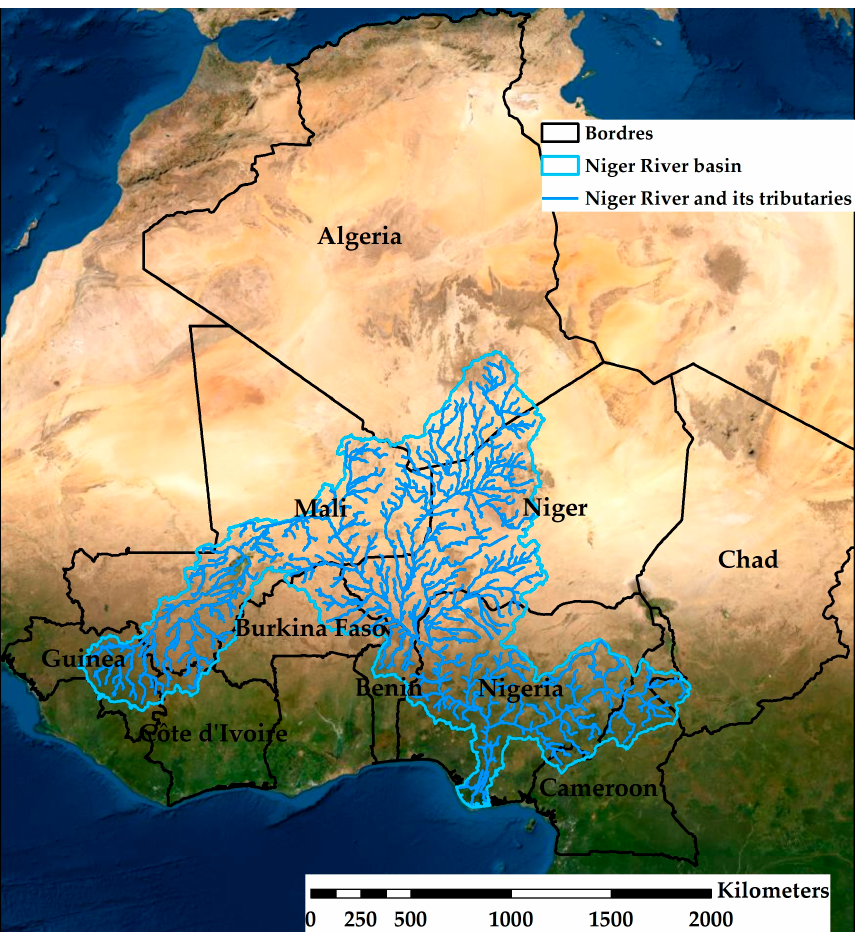
Figure 1. Map of the Niger River basin. The map shows the ten countries in the basin and the river’s tributaries. The map was constructed on a satellite image from the ESRI (Environmental Systems Research Institute) base map.